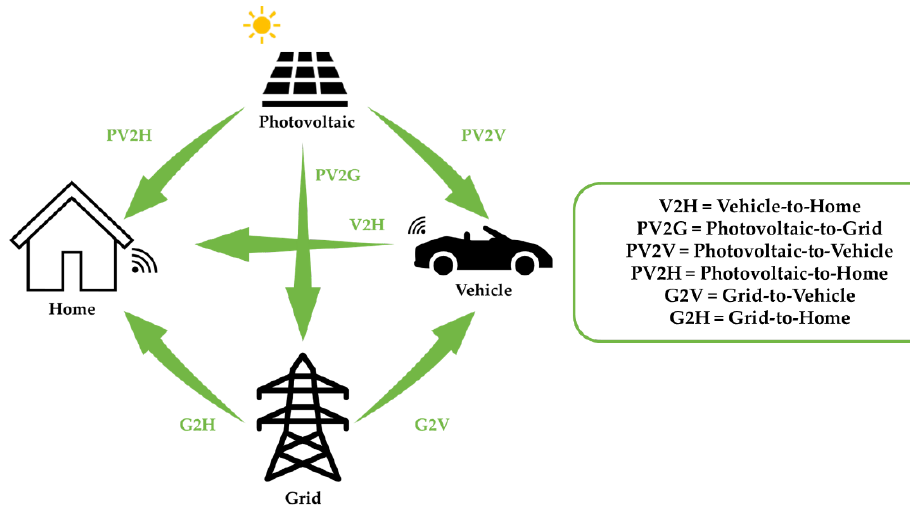
Figure 2. Illustration of V2H concept with main power flows.